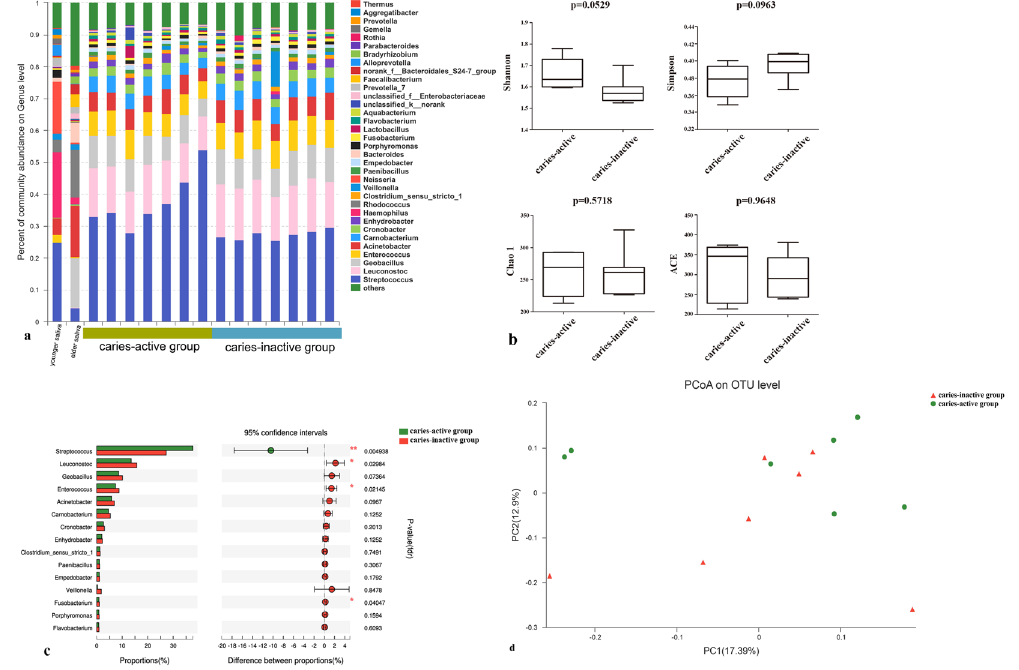
Figure 1. ( a ) Results of MTT test. Each value is the mean ± SD (n = 6). Values with stars on top are significantly different from each other. ( p < 0.001; t-test). ( b ) Result of lactic acid production test.